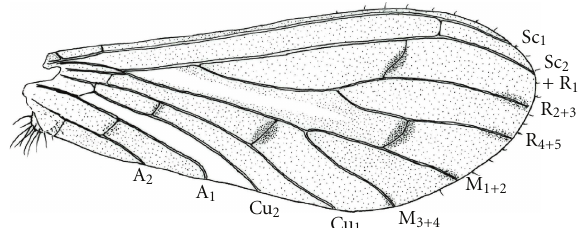
Figure 1: Incasemidalis lineatellus sp. n., fore